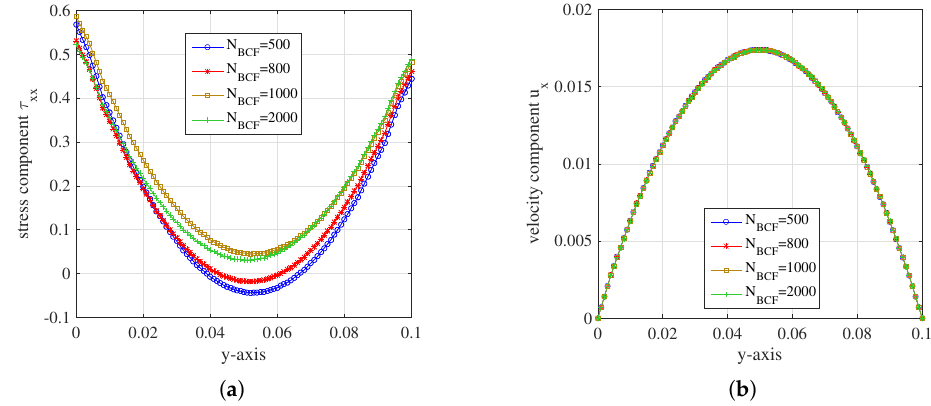
Figure 12. ( a ) Stress component τ xx ; and ( b ) velocity component u x on the y -axis during the steady state at t = 1.999185 for different N BCF of FENE model.